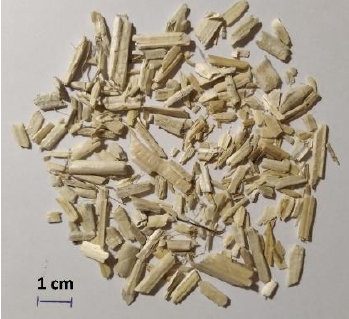
Figure 2. Hemp shives used in studies.